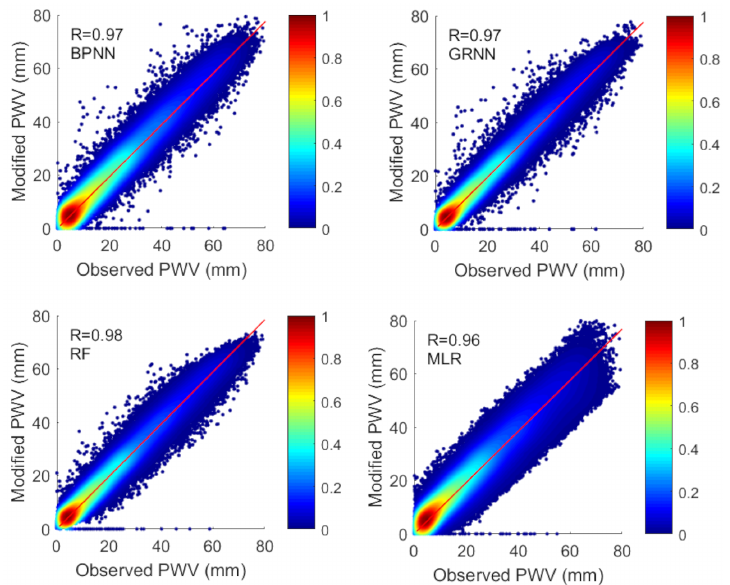
Figure 5. Scatter plots of Modified MODIS PWV (annual model) against observed (GNSS) PWV from all